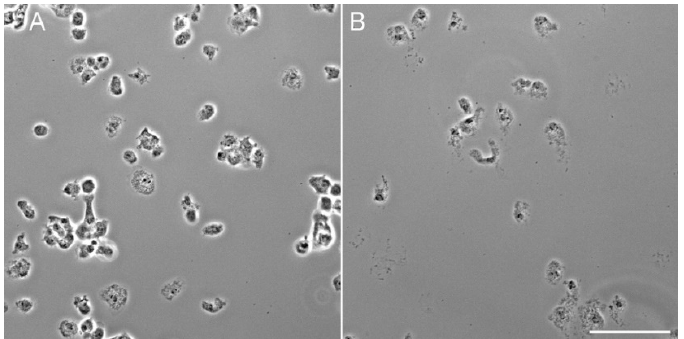
Figure 3. Phase contrast images of identical aliquots of D. discoideum cells spun onto coverslips and fixed ( A ) with or ( B ) without the addition of 0.05% glutaraldehyde and rinsed four times with buffer. Scale bar = 50 μ m.